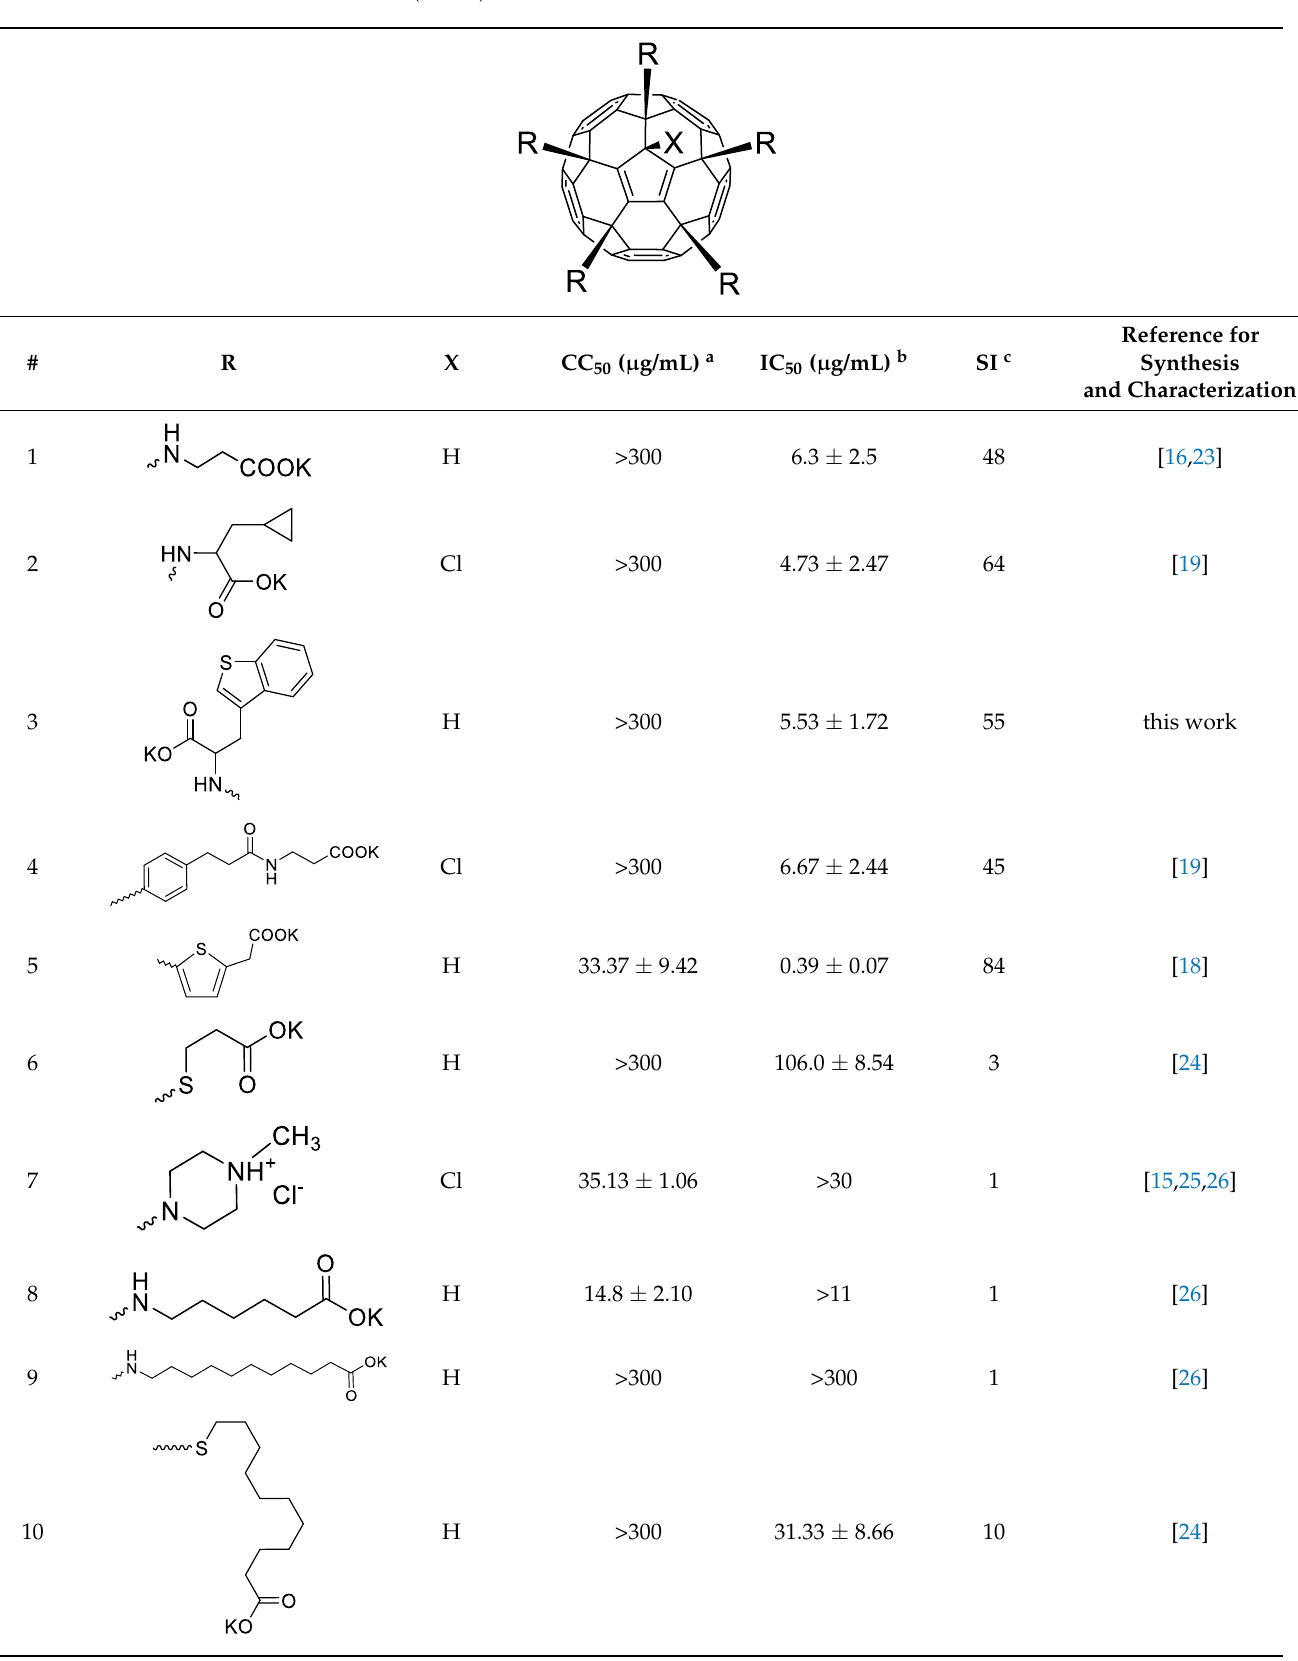
Table 1. Antiviral activity of the water-soluble fullerene derivatives against Influenza A/Puerto Rico/8/34 (H1N1) virus in MDCK cells.